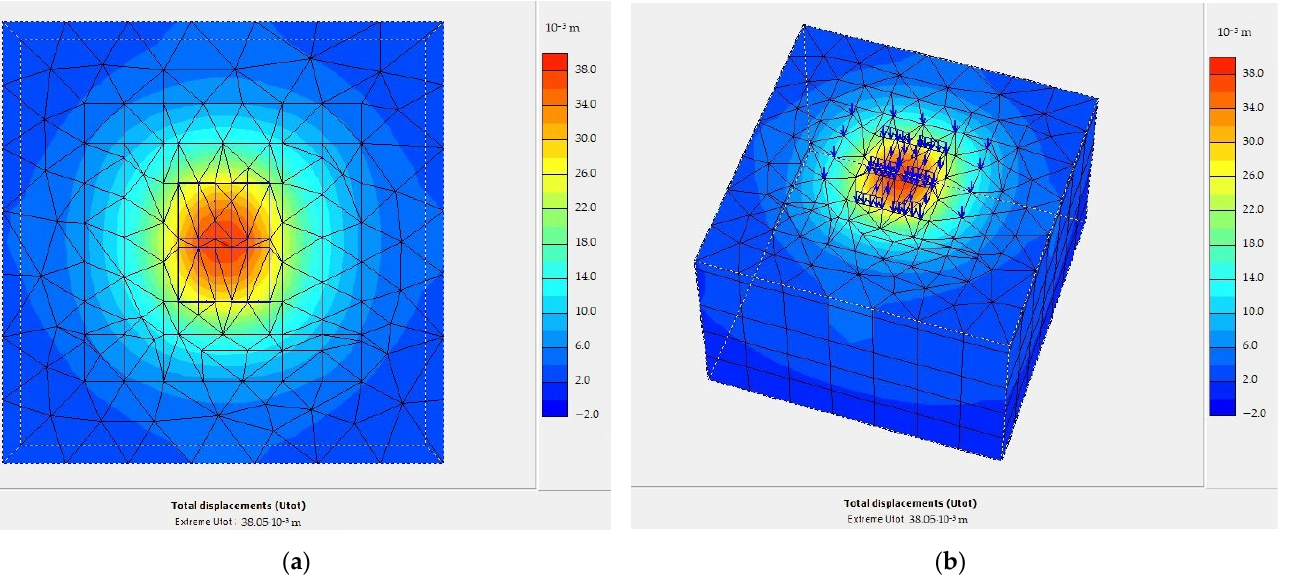
Figure 14. Numerical modeling in Plaxis 3D: ( a ) loading scheme; ( b ) volumetric strains.